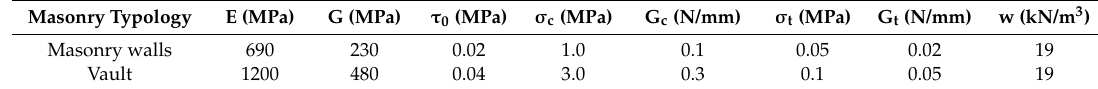
Table 1. Mechanical properties of the masonry adopted in the numerical model.